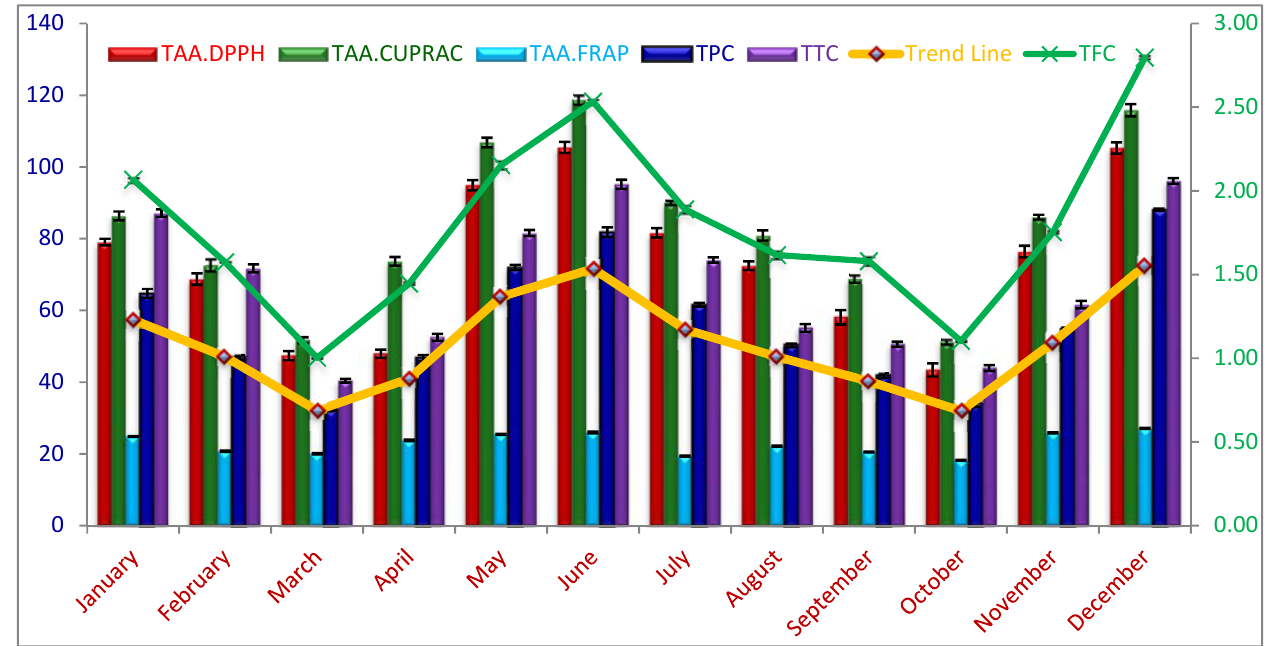
TPC: total phenolic content; TFC: flavonoids content, TTC: tannin content; CUPRAC: CUPric reducing antioxidant capacity; FRAP: ferric reducing antioxidant power. DPPH: 1,1-diphenyl-2-picrylhydrazyl; GAE: gallic acid equivalent, CtE: catechol equivalent, AAE: Ascorbic acid equivalent.